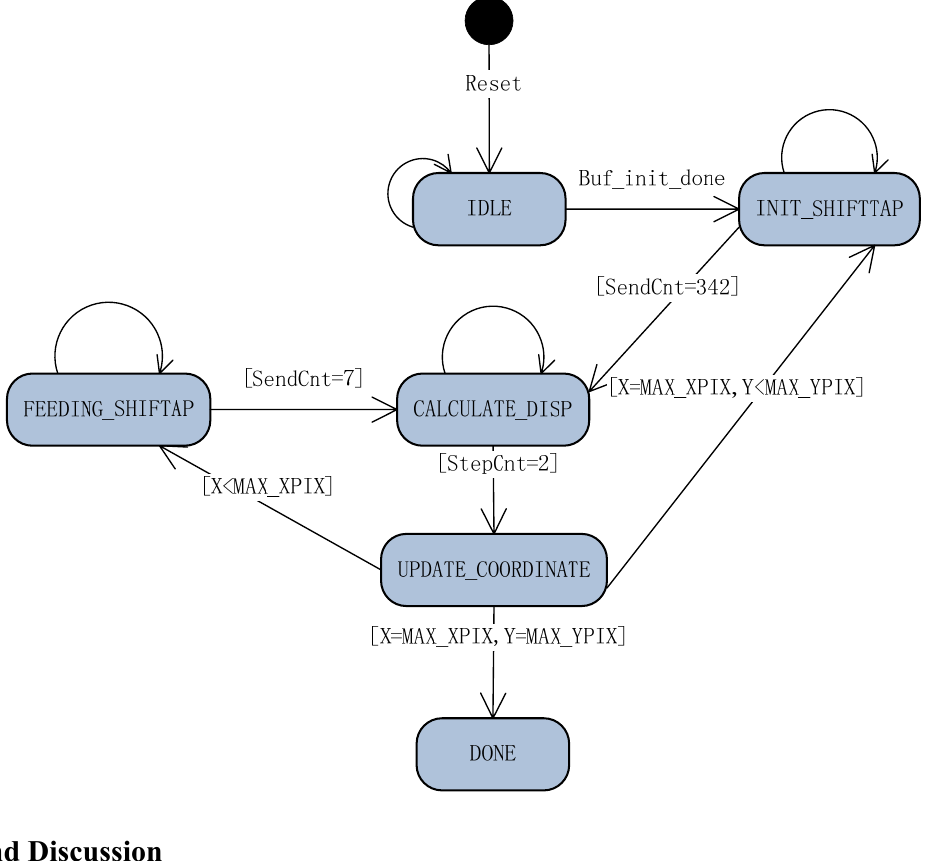
Figure 9. Finite State Machine of the Stereo Matching Process Control.